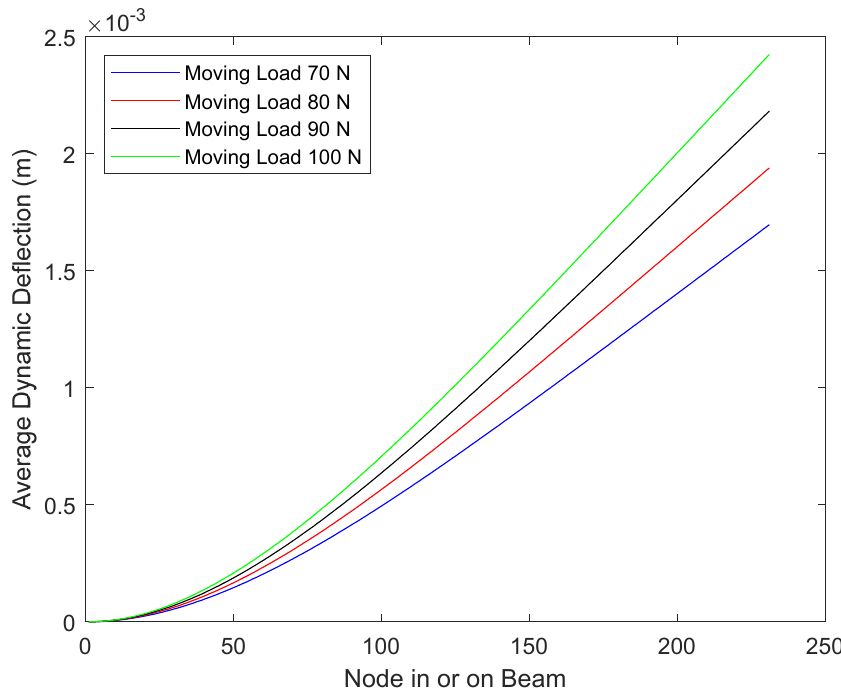
Figure 11. Average Dynamic Deflection of Cracked Beam (crack at x / l = 0.70) under moving load. It can be observed in Figures 12 and 13 that the average dynamic deflection of the uncracked beam was the lowest. However, it cannot be used to indicate the crack position in a cracked beam.